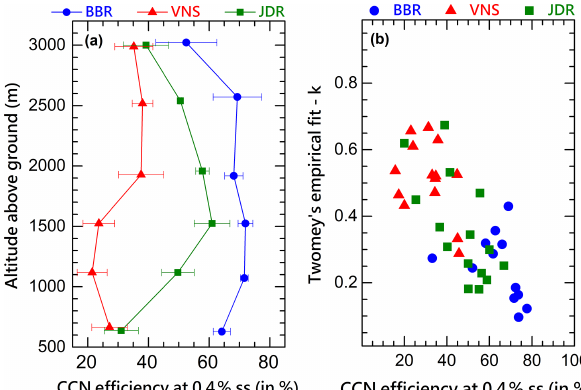
Figure 8. Vertical distribution of the (a) mean CCN activation ef- ficiency at 0.4% supersaturation and (b) variation of k values with the corresponding CCN efficiency at 0.4% supersaturation over the eastern (BBR; circle), central (VNS; triangle) and western (JDR; square) IGP regions. Error bars represent the standard error of the